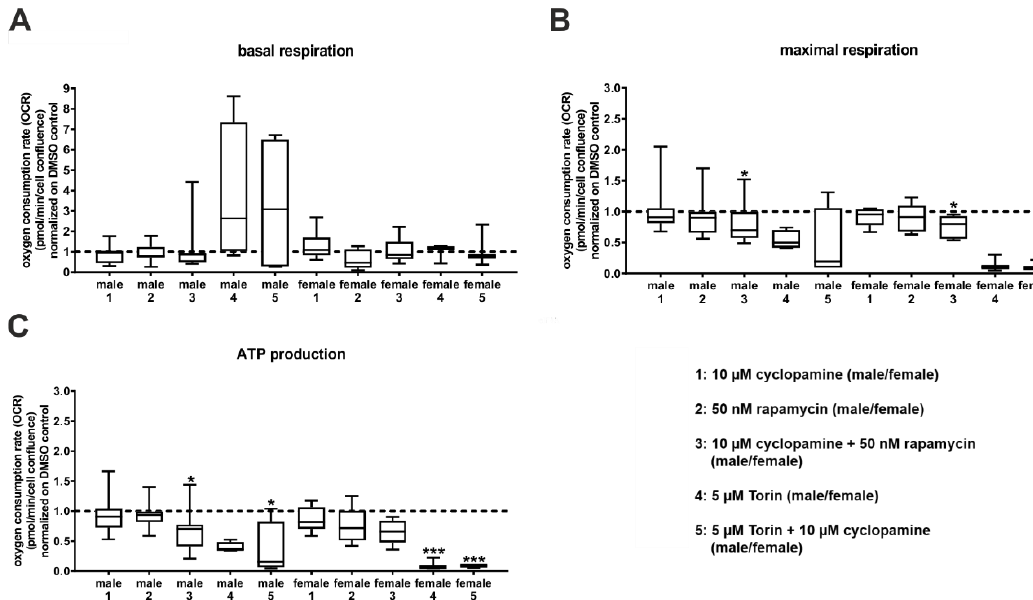
Figure 5. Combinatory effects of Hedgehog and mechanistic target of rapamycin inhibitors on mitochondrial respiration. Mito stress test analysis of primary hepatocytes from C57BL/6N mice. The oxygen consumption rate (OCR) was measured with the Seahorse analyser. The dashed line shows the DMSO control. ( A ): Basal respiration. ( B ): Maximal respiration. ( C ): Adenosine triphosphate (ATP) production. Significance was calculated with one-way ANOVA for repeated measurements. Stars show the significance to DMSO control. * p ≤ 0.05, *** p ≤ 0.001; n = 3–4.